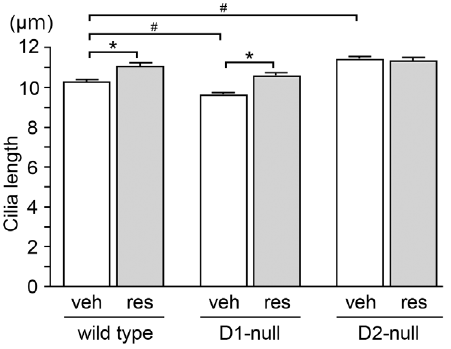
Figure 3. Mice with genetically-inactivated dopamine recep- tors displayed altered lengths of striatal neuronal cilia. Eight- week-old D1-null mice, D2-null mice and their wild-type littermates on the C57BL/6J background were treated for 3 days with reserpine (3 mg/ kg, s.c.) or vehicle. The average length of at least 200 neuronal cilia in the dorsolateral striatum from each of four mice in the respective groups was calculated; the data are means 6 SEM of four average values per group (the wild-type groups contained two D1-littermates and two D2-littermates). The vehicle-treated D1-null and D2-null mice revealed significantly shorter and longer neuronal cilia, respectively, compared to the vehicle-treated wild-type controls ( # P , 0.05). Reser- pine-treated wild-type and D1-null mice, but not D2-null mice, displayed significantly longer neuronal cilia compared to vehicle- treated animals (* P ,